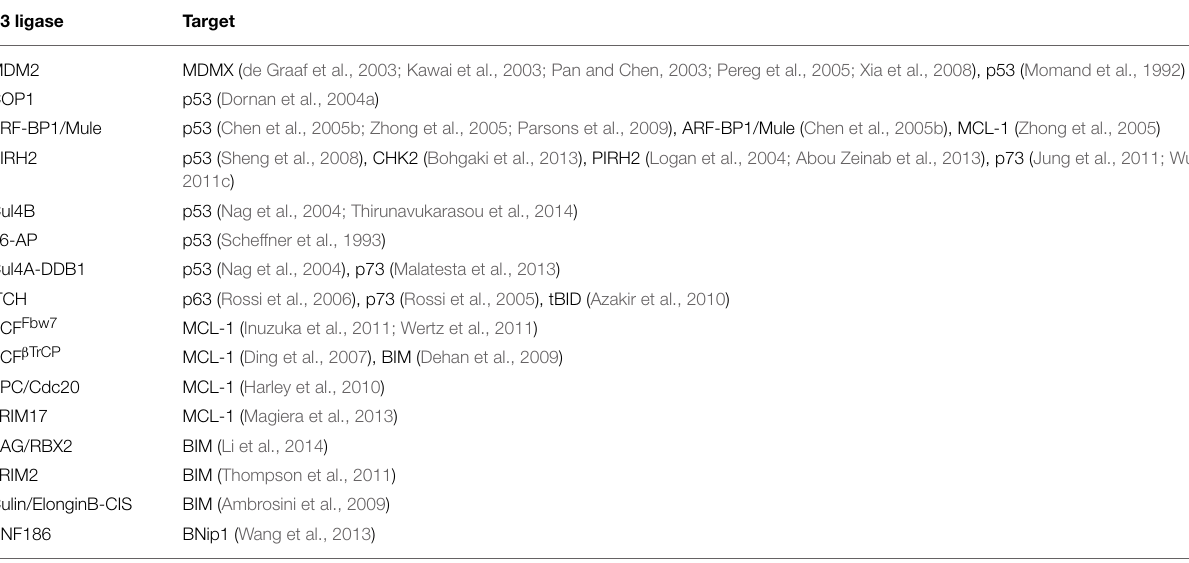
TABLE 1 | E3 ligases involved in DDIA.